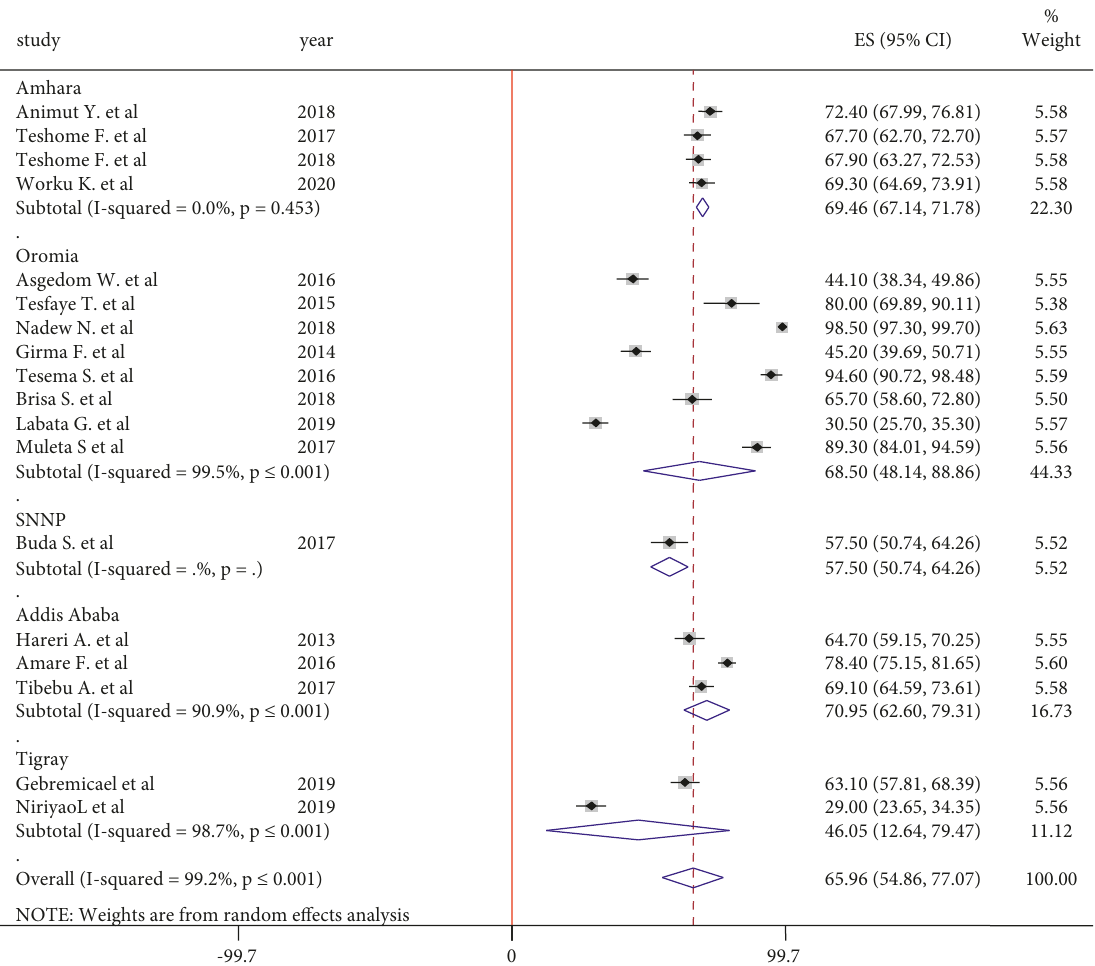
Figure 5: Forest plot on adherence to low-salt diet among hypertensive patients in